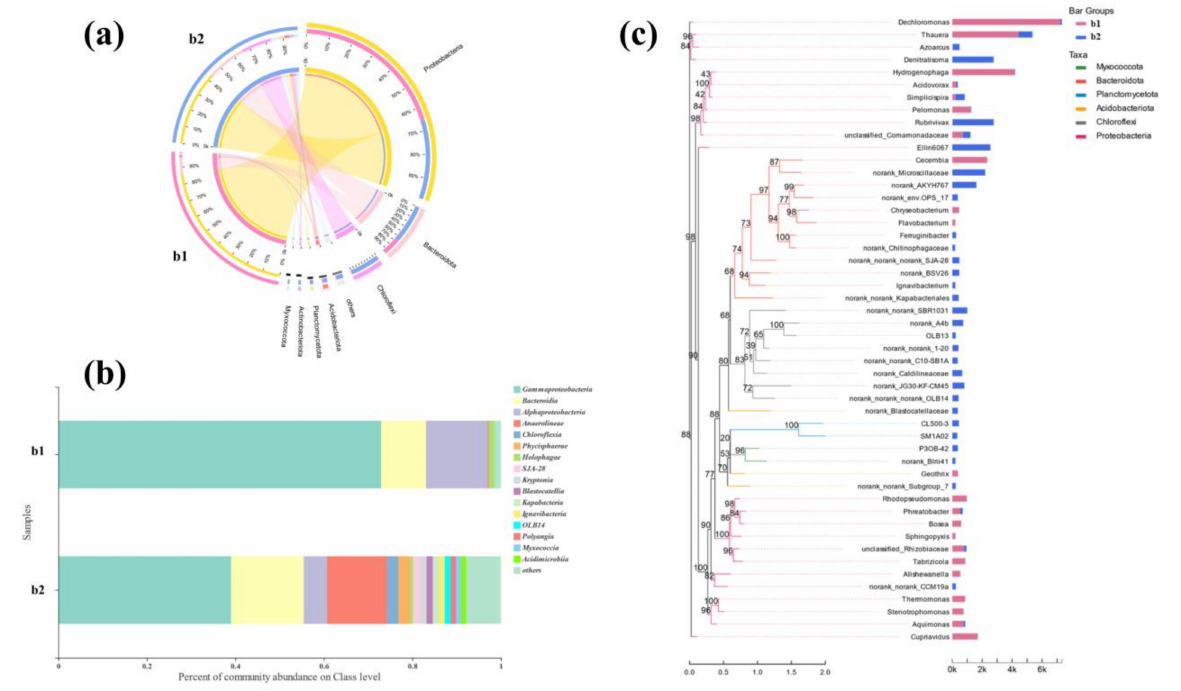
Figure 9. Relative abundance of samples at ( a ) Phylum level; ( b ) Class level; ( c ) Genus